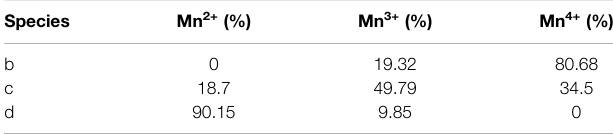
TABLE 1 | Surface species of low-grade pyrolusite before and after microwave heating. Species